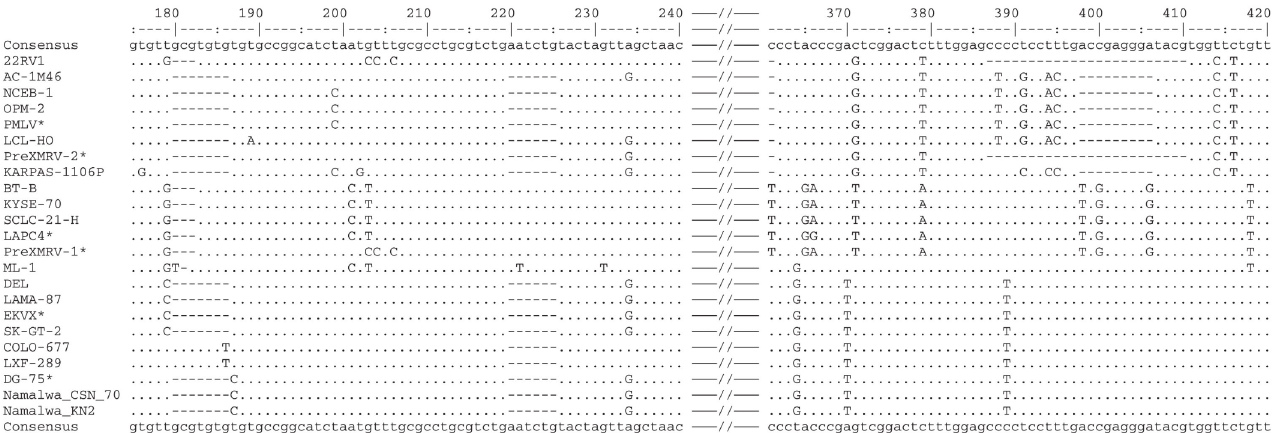
Fig 3. Nucleotide sequence alignment of MLV infected cell lines. The multiple sequence alignment was performed using Vector NTI. The multiple sequence file was then imported to showalign of the EMBOSS program collection. The numbers determine the position from the forward primer. Missing nucleotides are represented by a dash and nucleotides different to the consensus sequence are represented by the respective character. * Cell line sequences originating from the NCBI database.